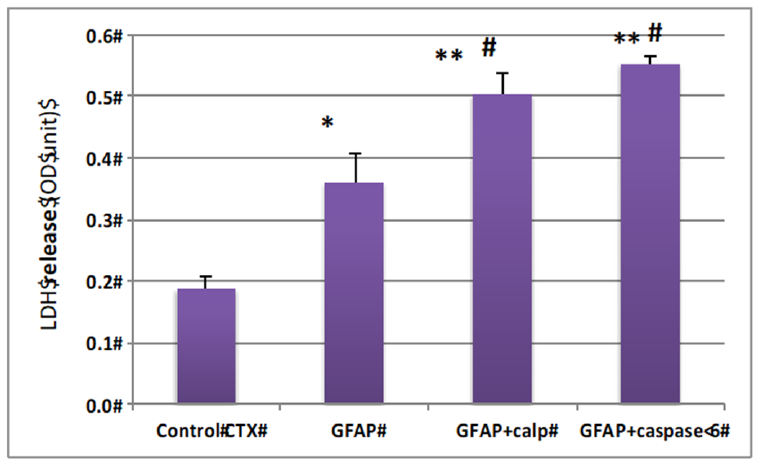
Figure 5 . GFAP protein and GBDP are neurotoxic to rat cerebrocortical culture. Cultured cells were treated with 500 ng GFAP fragment (calpain or caspase-6 digestion) * compared with control p < 0.05, ** compared with control p < 0.01; # compared with intact GFAP treatment, p < 0.05.